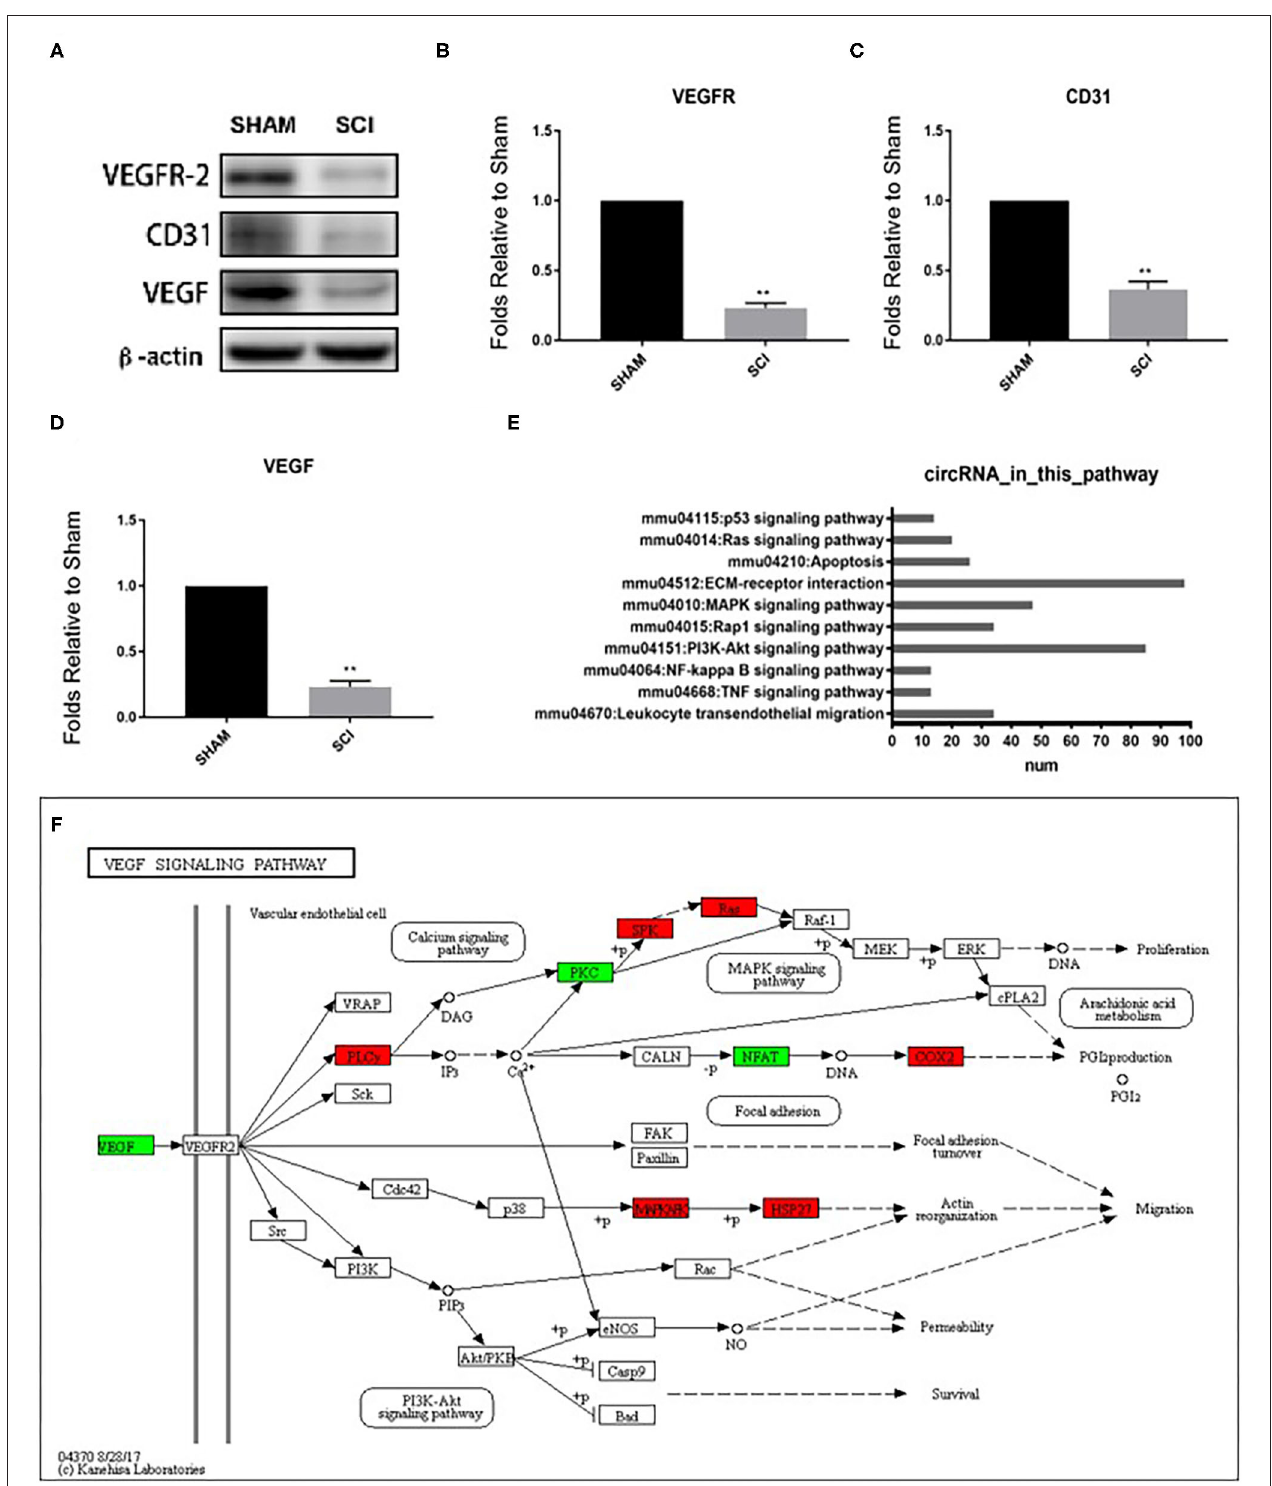
FIGURE 5 | Detection of vascular endothelial proliferation, migration, and angiogenesis responses after SCI and quantification of CD31, VEGF, and VEGFR protein levels 3 days post SCI by western blot (A–D) . Analyses of the protein bands measured normalized to the signal of β -actin. Expression levels of proteins in the SCI group are expressed as fold change compared to sham values. ** p < 0.01 significant compared with the sham group. Data are presented as the mean ± SEM, n = 5. (E) The number of circRNAs participating in the pathways associated with vascular endothelial proliferation, migration, and angiogenesis based on KEGG results. (F) KEGG map04370 shows the VEGF